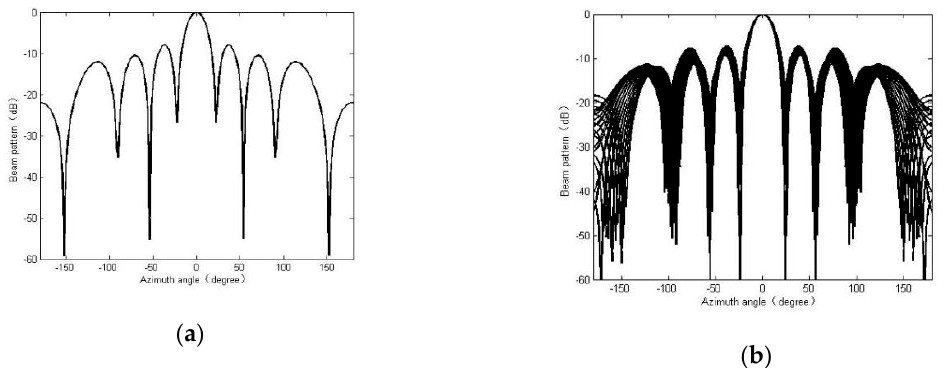
Figure 4. Experimental comparison of focusing frequency at 2900 Hz. ( a ) Narrowband beam pattern at 2900 Hz; ( b ) broadband beam pattern focused on the focusing frequency of 2900 Hz.